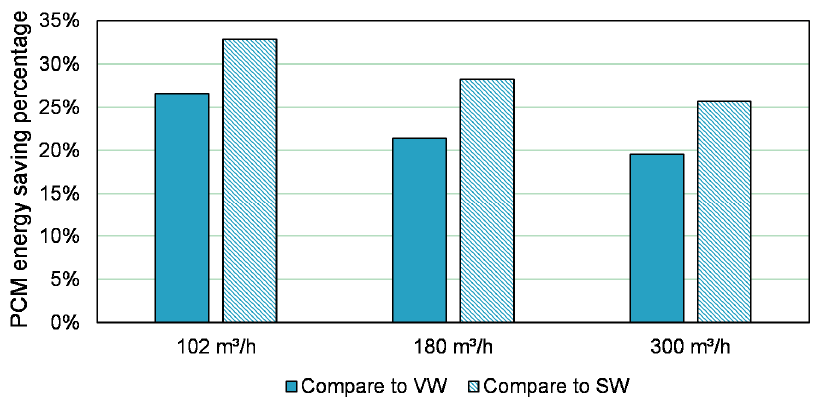
Figure 22. The PCM energy-saving potential during the winter period compared to the two reference